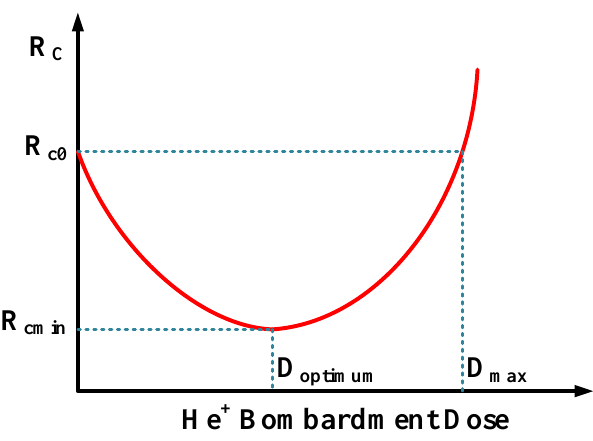
Figure 10. Schematic representation of the specific contact resistance (R c ) after annealing vs. He + bombardment dose.